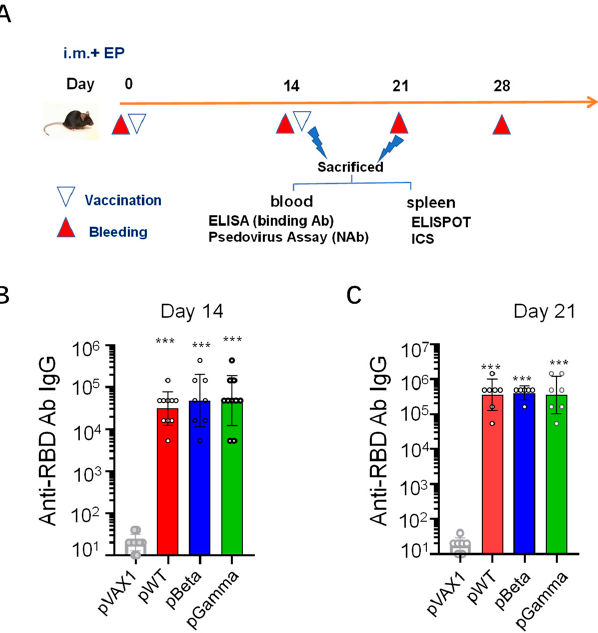
Figure 1. Design, construction, and identification of DNA vaccine against various SARS-CoV-2 variants. ( A ) Spike protein of the wild type, Beta and Gamma variants of SARS-CoV-2 for DNA vaccine constructs, ( B ) restriction enzyme analysis of each DNA construct using BamH I and Xho I, with DL5000 DNA Marker (Takara) was used as a DNA marker, ( C ) Western blot analysis of cell lysates from plasmid-transfected HEK-293 cells over 48 h, with PageRuler™ Plus Prestained Protein Ladder 10–250 kDa used as a protein marker. “NC” represents negative control which was the cells transfected with the pVAX1 vector, and “Spike” refers to the commercial spike protein of wild-type SARS-CoV-2 (ACRO Biosystem, Beijing, China) which served as the positive control.